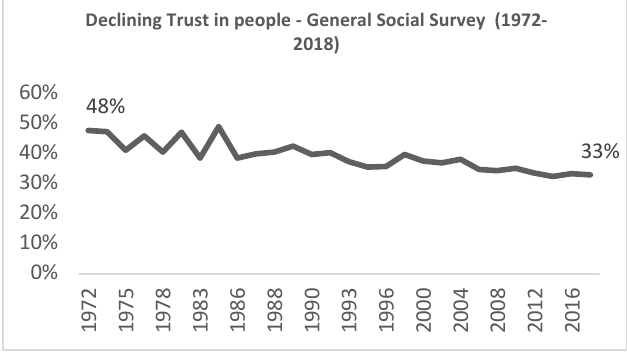
Figure 1. General social survey (GSS) ‘Can people be trusted’ (1972–2018 dataset). Declining trust among people with only 33% responding that they can trust other people as compared to 48% in 1972